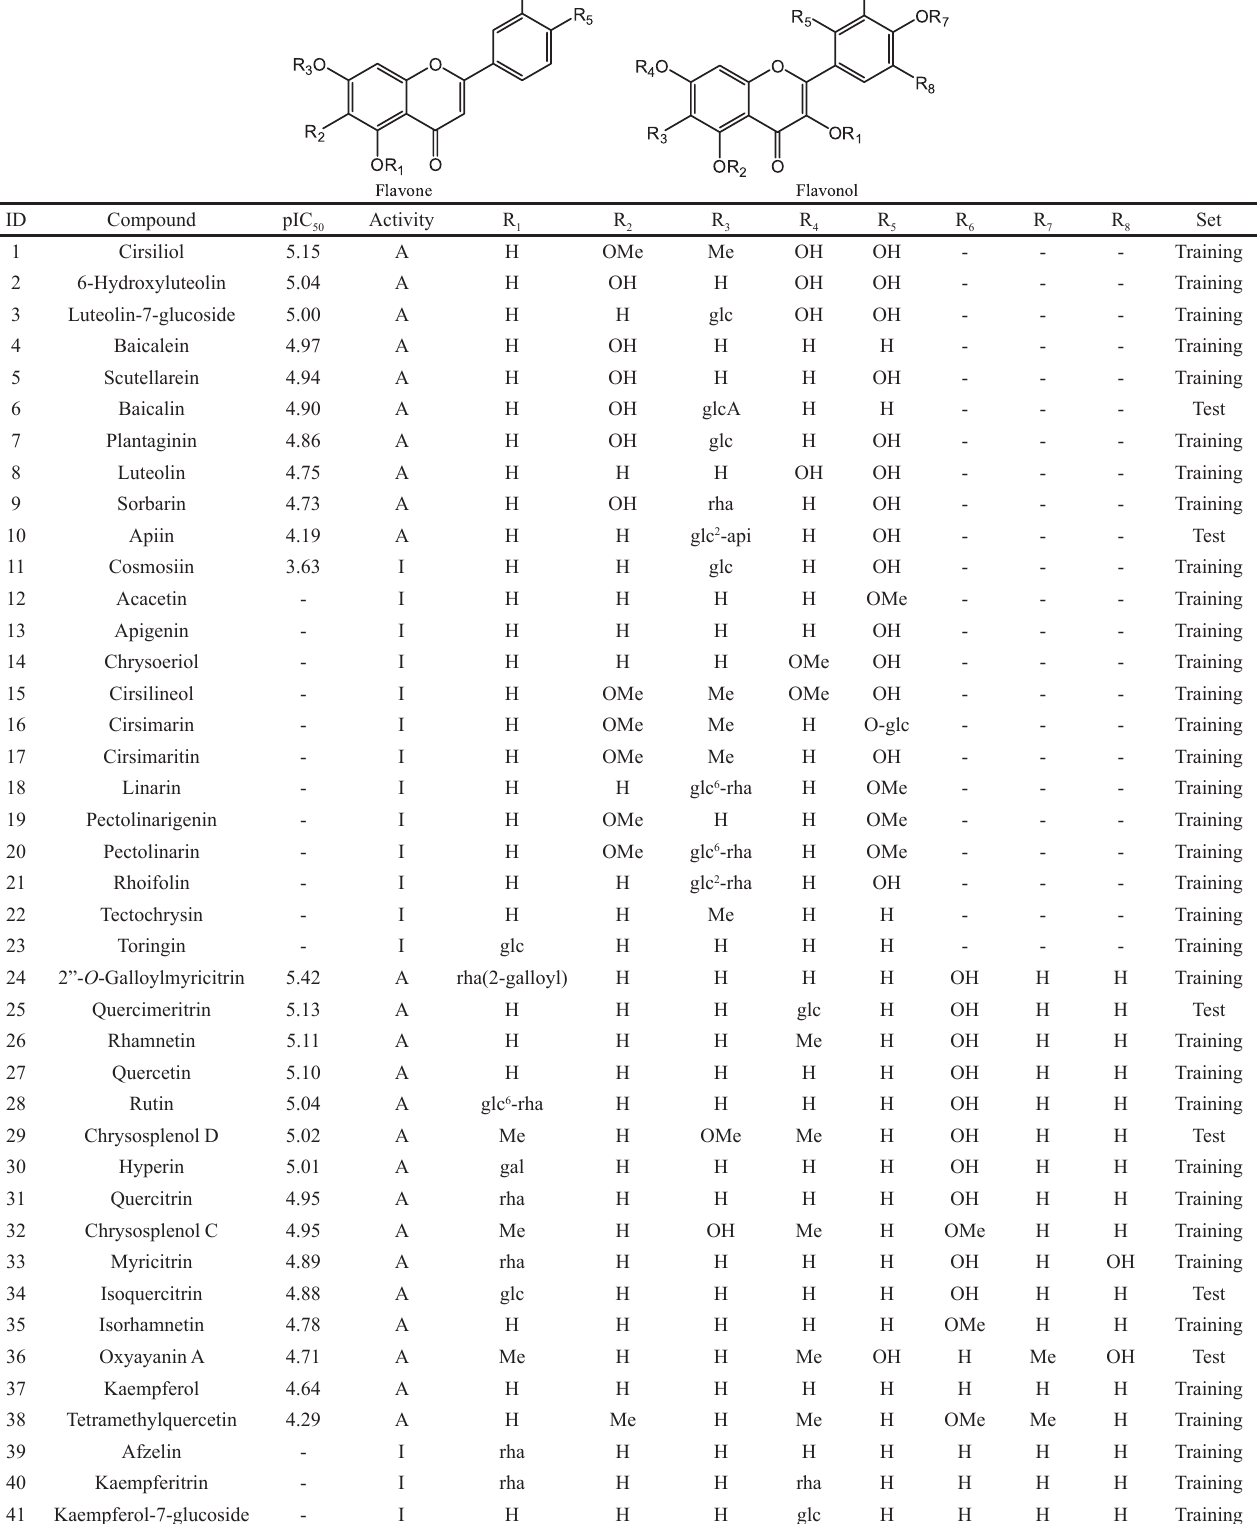
TABLE I - List of compounds, substitutions and its respective log of biological activity. The compounds were classified as Active (A, IC <200mM) or Inactive (I, IC >200mM) for the Kohonen study: the respective training and test 50 50